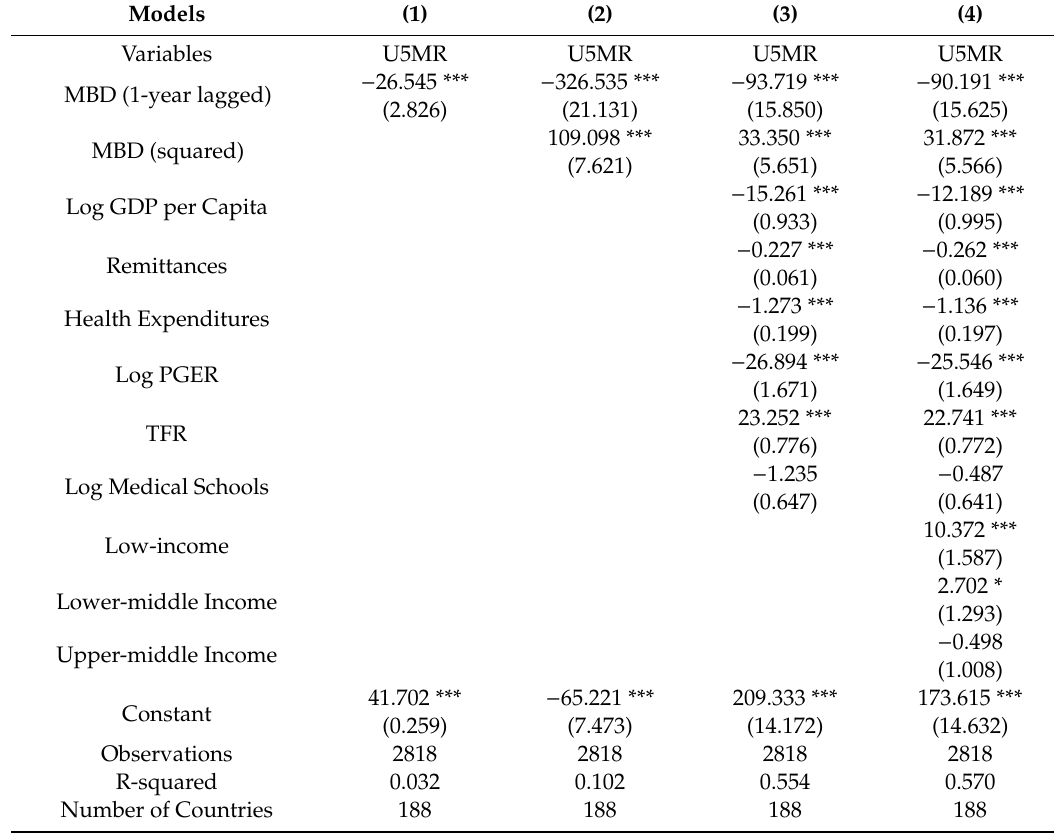
Table 5. Fixed-e ff ects regression of MBD (1-year lagged) on U5MR in 188 countries over 2000–2015.